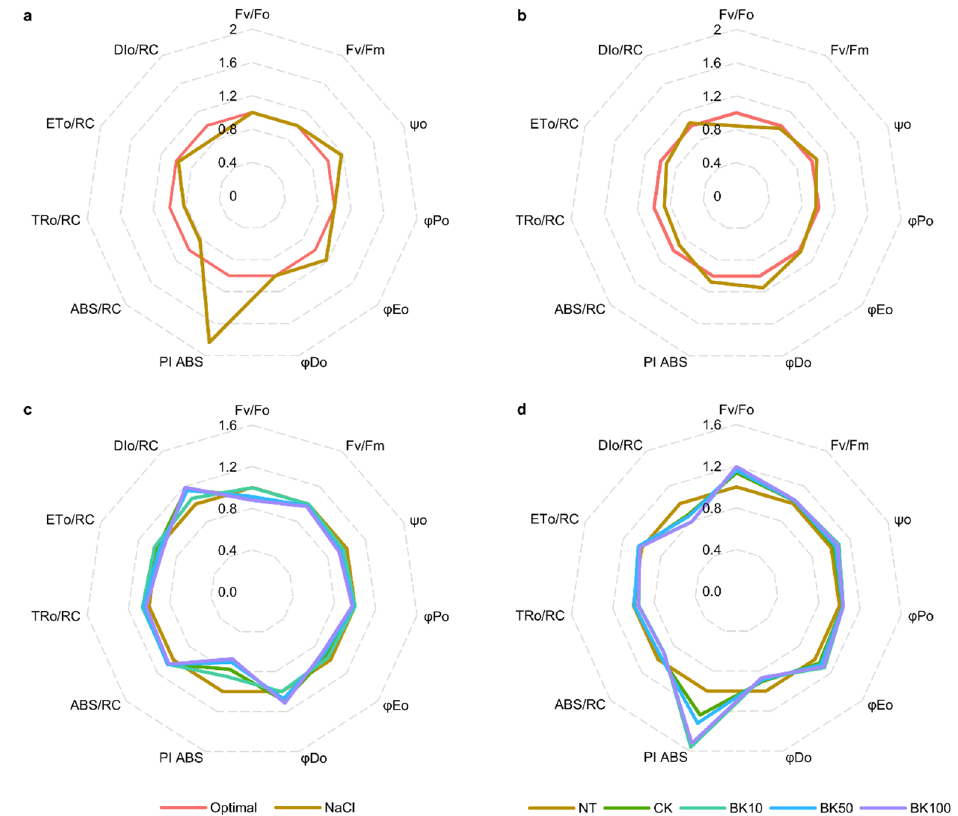
Figure 7. Diagrams presenting photosystem II efficiency under salinity ( a , b ) and after bikinin treatment (non-treated; treated with 0.11% DMSO; and treated with 10 µ M, 50 µ M, and 100 µ M bikinin (BK10, BK50, and BK100, respectively) dissolved in 0.11% DMSO (CK)) ( c , d ) in Golden Promise ( a , c ) and Haruna Nijo ( b , d ). Values represent the mean and standard error for 6 biological replicates. The results of HSD Tukey test analysis are shown in Table S4. Fv/Fo, PSII potential activity; Fv/Fm, PSII maximum photochemical efficiency; Ψ o, probability (at t = 0) that a trapped excitation moves an electron into the electron transport chain beyond QA; ϕ Po, maximum quantum yield of primary photochemistry (at t = 0); ϕ Eo, quantum yield of electron transport (at t = 0); ϕ Do, quantum yield (at t = 0) of energy dissipation; PI ABS, performance index (potential) for energy conservation from an exciton to the reduction of intersystem electron acceptors; ABS/RC, absorption flux (of antenna Chls) per RC; TRo/RC, trapping flux (leading to QA reduction) per RC; ETo/RC, electron transport flux (further than QA − ) per RC; DIo/RC, dissipated energy flux per RC (at t = 0). The results of HSD Tukey test analysis are presented in Table